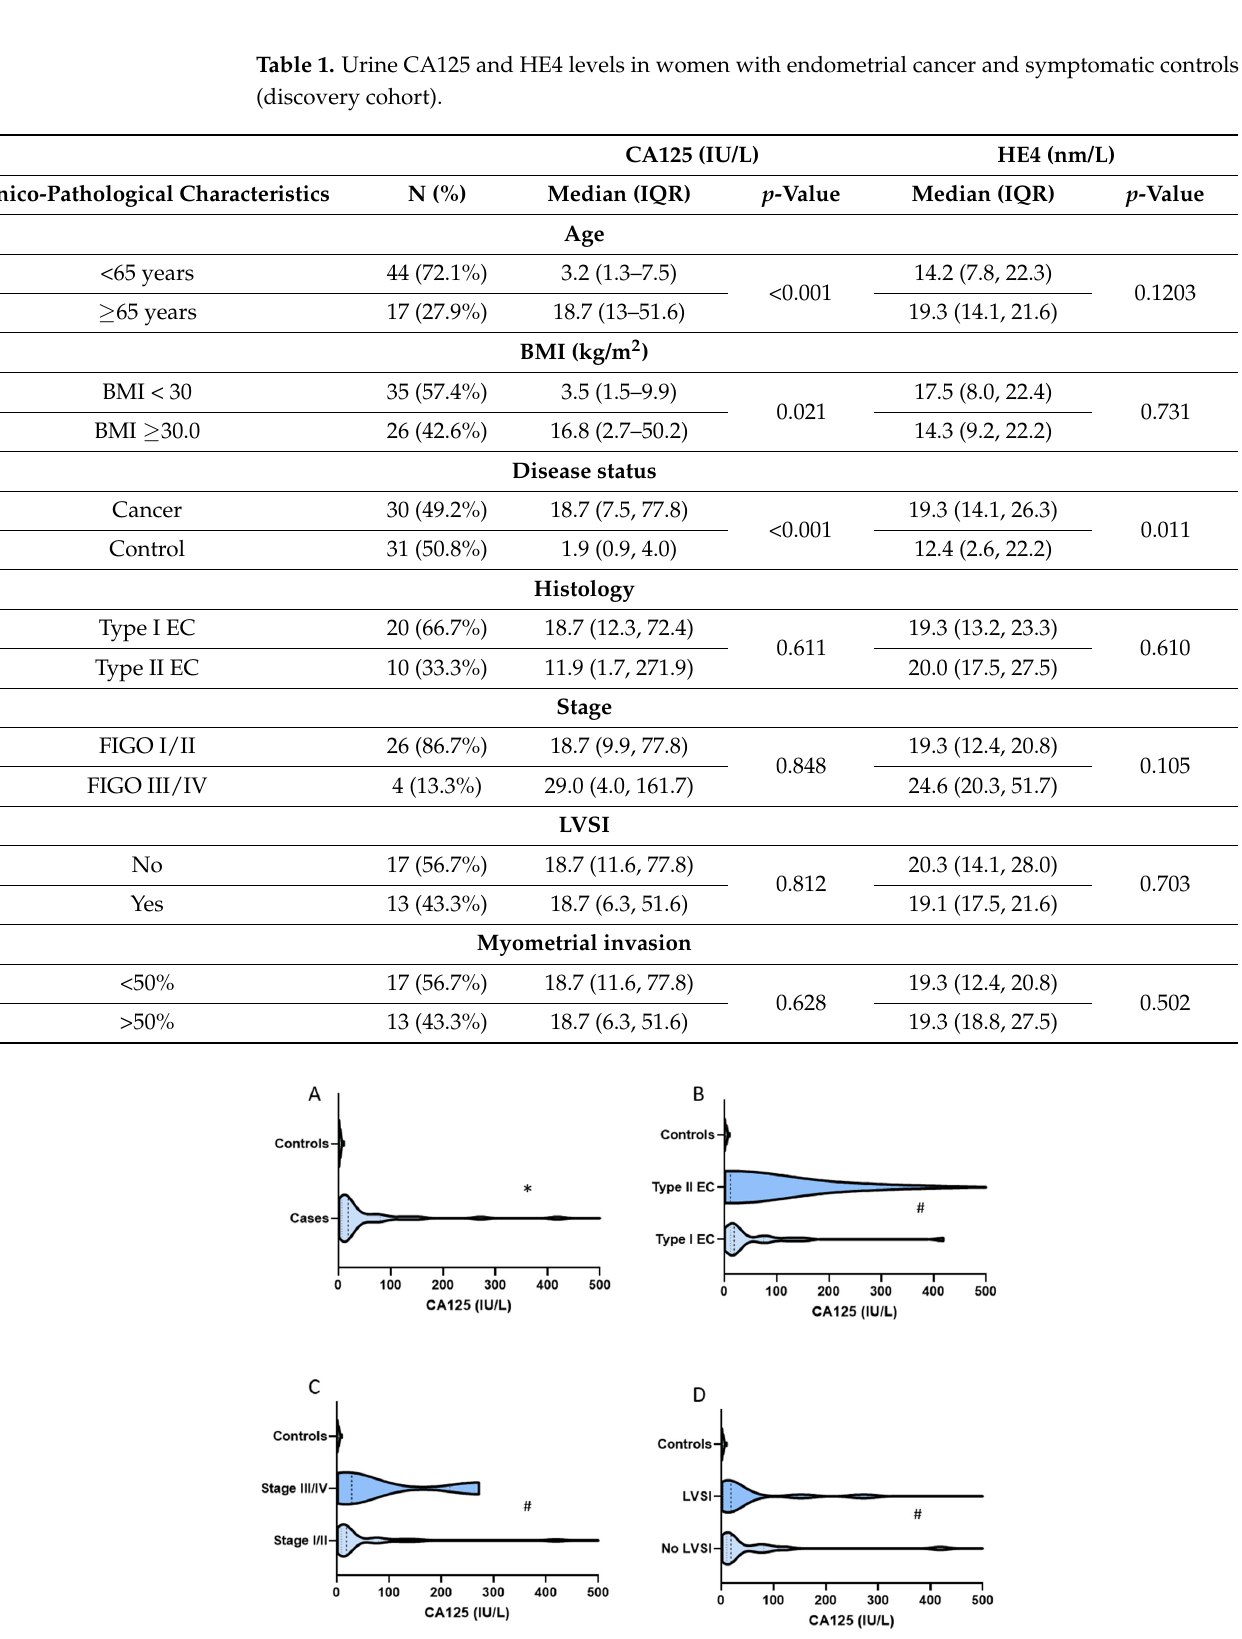
Table 1. Urine CA125 and HE4 levels in women with endometrial cancer and symptomatic controls (discovery cohort).